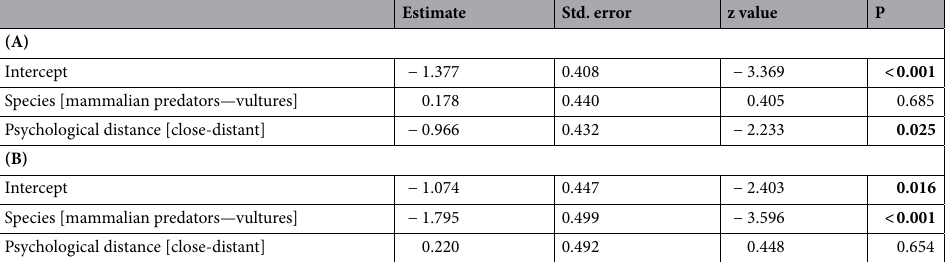
Table 1. Logistic regression mixed models to evaluate: (A) the influence of species and psychological distance on the probability of receiving comments proposing a lethal strategy to deal with species involved in negatively framed videos of vultures and mammalian predators, (B) the influence of species and psychological distance on the probability of receiving empathetic comments toward species involved in negatively framed videos of vultures and mammalian predators. Statistically significant results are indicated in bold. The estimates of the species and psychological distance variables correspond to “vultures” and “distant psychological distance”. The best models containing both predictors (species and psychological distance) are reported in this table (for model comparisons see Supplementary Table S3).